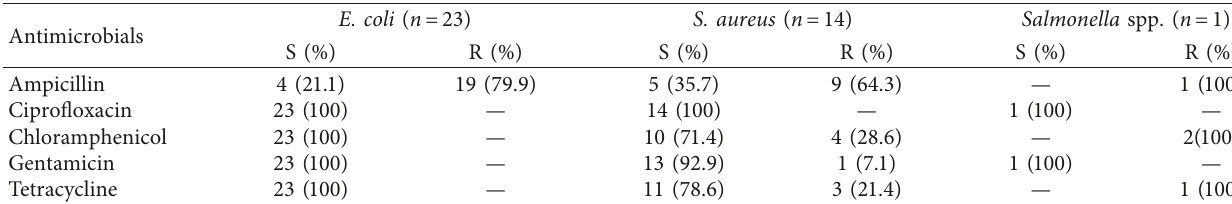
Table 7: Drug sensitivity pattern of isolated bacteria.